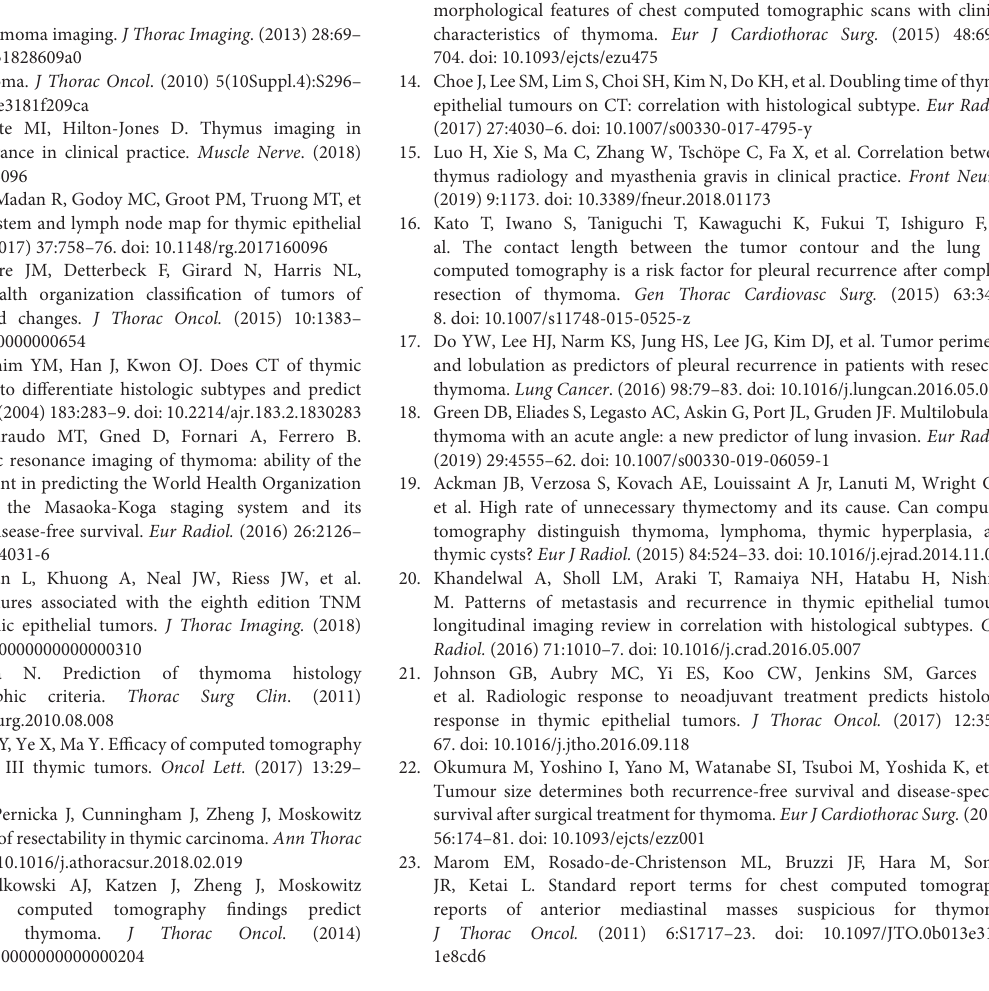
Supplementary Table 1 | Clinical information and imaging features of patients in the training and validation cohorts. Supplementary Table 2 | Risk factors for imaging features models. Supplementary Table 3 | Evaluation of the imaging features models among cohorts. Supplementary Table 4 | Evaluation of individualized nomogram among